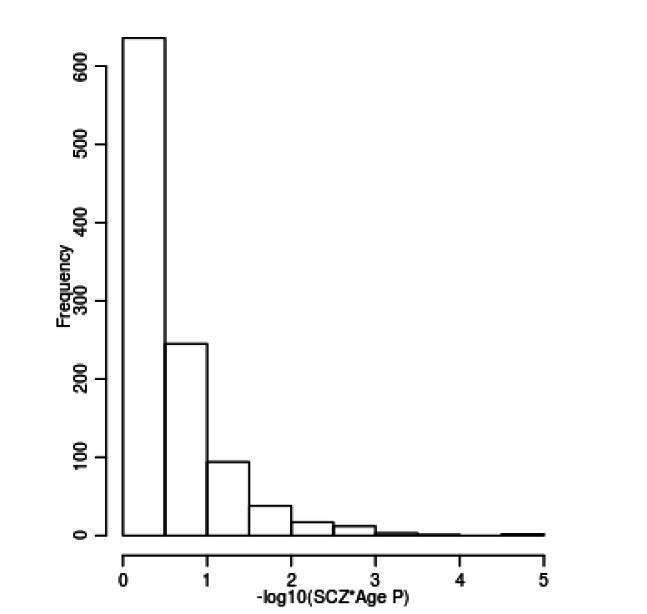
Limited evidence for a relationship between age and DNAm at SZ-associated DMPs.Shown is a histogram of –log10(p-values) for the interaction term between age and schizophrenia status across all 1,048 SZ-associated DMPs.